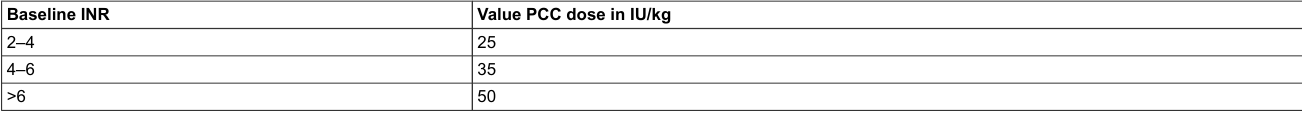
Table 6: Administration of prothrombin complex concentrate (PCC) according to baseline international normalised ratio (INR) value in major bleeding on vitamin K antagonists. Baseline